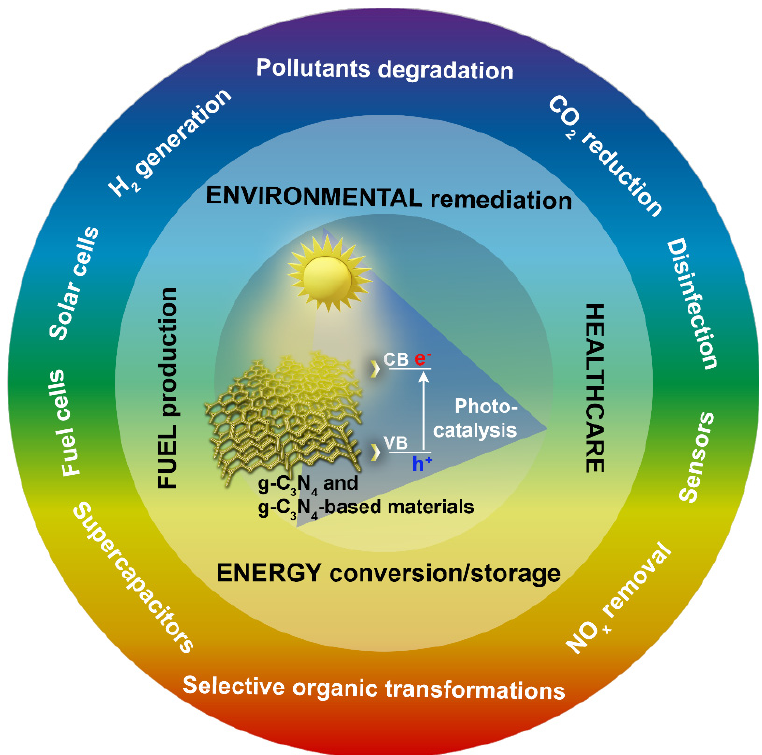
Figure 3. Schematic presentation of the fundamentals of the photocatalysis of g-C 3 N 4 - and g-C 3 N 4 - based materials and their potential applications in the fields of environmental remediation, healthcare, energy conversion and storage, and fuel production.